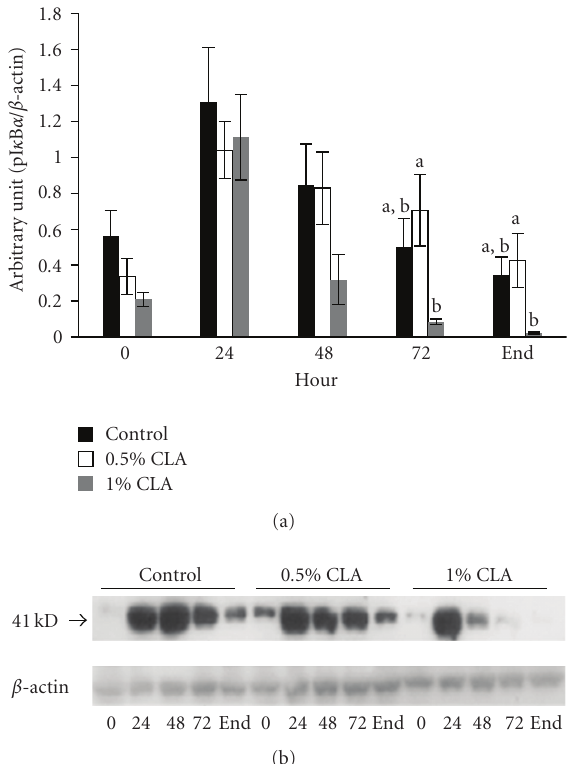
Figure 4: pI κ B α protein expression in cutaneous wounds of mice fed diets containing 0 (control), 0.5%, or 1% CLA for 2 weeks. (a) Quantified pI κ B α protein expression levels determined by densitometry. Values are mean ± SEM; N = 4 to 6 in each group. Means at a time with a di ff erent letter are significantly di ff erent, P < . 05. (b) 0; 0hr, 24; 24 hr, 48; 48 hr, 72; 72 hr after wounding, end (wound is completely